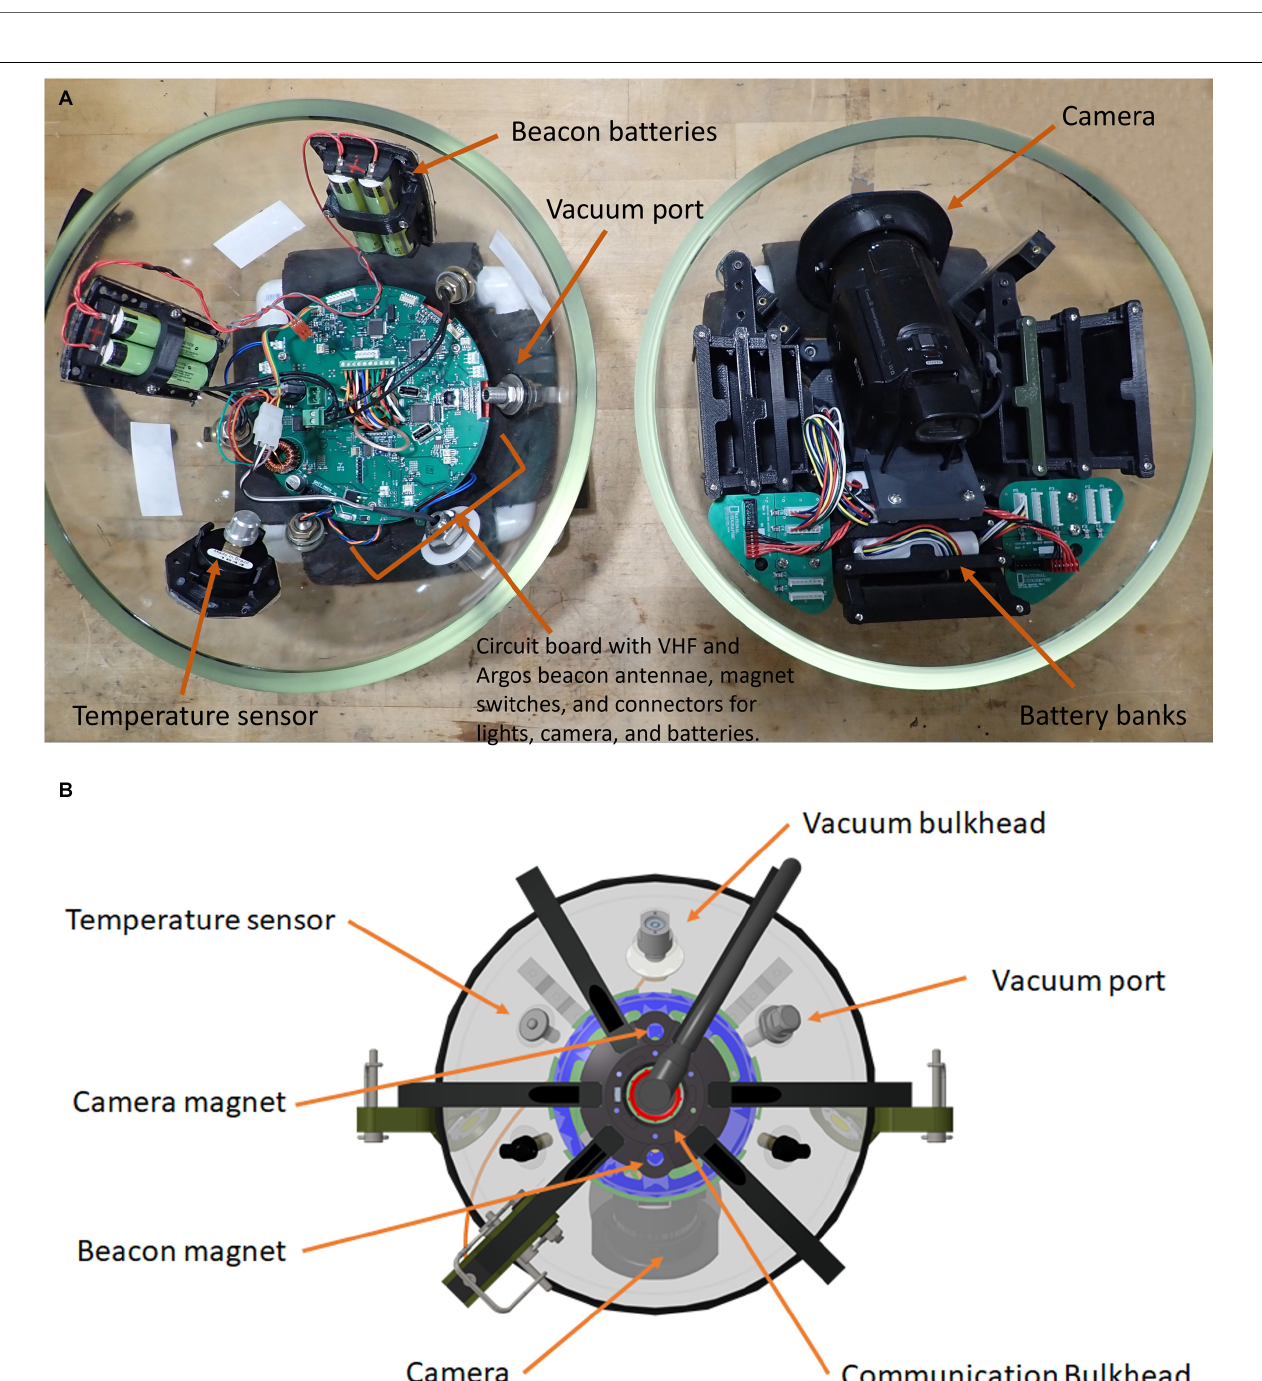
FIGURE 2 | (A) Two hemispheres of the NGS deep-sea camera system; lower hemisphere (right) contains the high definition (HD) camera; upper hemisphere (left) contains the Argos satellite beacon and VHF beacon, and the electrical bulkhead for data download and battery charging; (B) outside view diagram of upper hemisphere; communication bulkhead in the center, along with magnets, sensors, and vacuum port.